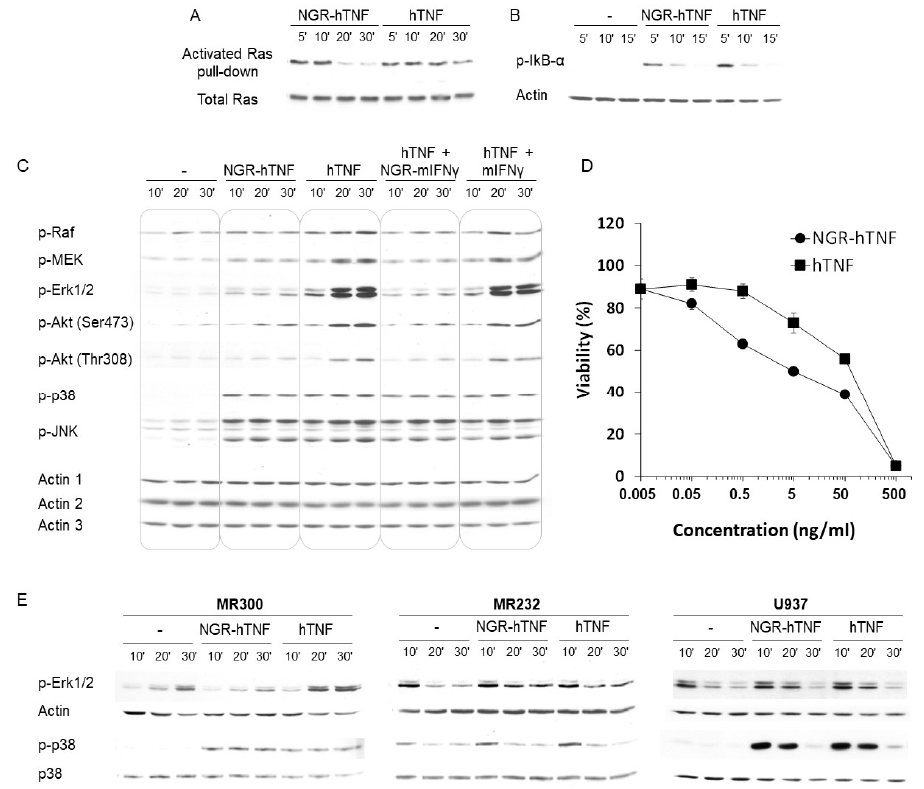
Figure 5. NGR-hTNF and hTNF cell signaling in CNGRC-binding and CNGRC-non-binding cell lines.